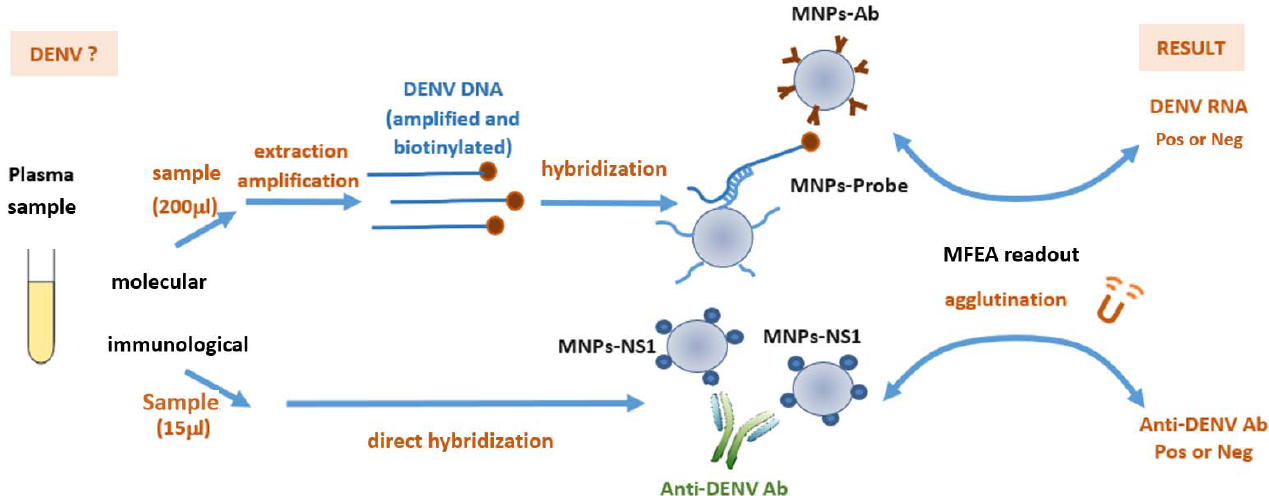
Figure 1. Diagnostic of dengue virus (DENV) infection by magnetic field-enhanced agglutination readout (MFEA readout). The molecular MFEA readout aims to detect the DENV RNA during the acute phase of infection. DENV genomes are extracted and amplified using asymmetric pan-flavivirus RT-PCR amplification. The biotinylated DENV amplicons are captured between magnetic nanoparticles (MNPs) grafted with specific DENV tetrathiolated DNA probes (MNPs-Probe) and anti-biotin antibodies (MNPs-Ab). The immunological MFEA approach aims to detect the anti-DENV antibodies in plasma samples during the convalescent phase of infection. These antibodies are captured between MNPs grafted with viral DENV NS1 antigens (MNPs-NS1) in a homogeneous phase.